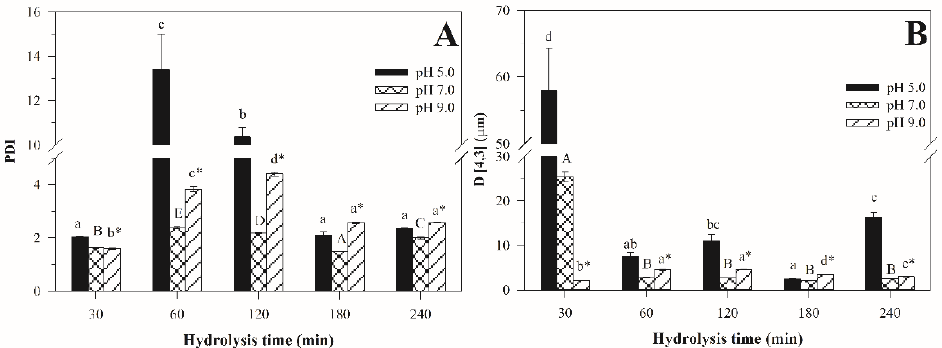
Figure 6. Effect of pH on polydispersity index (PDI, A ) and volume-weighted mean particle diameter (D [4,3], B ) of emulsions stabilized with H – Pan obtained at different hydrolysis times. Different letters indicate significant differences ( p < 0.05) between the hydrolysis time at a specified pH. *: Visual guide for the reader in treatments at pH 9.